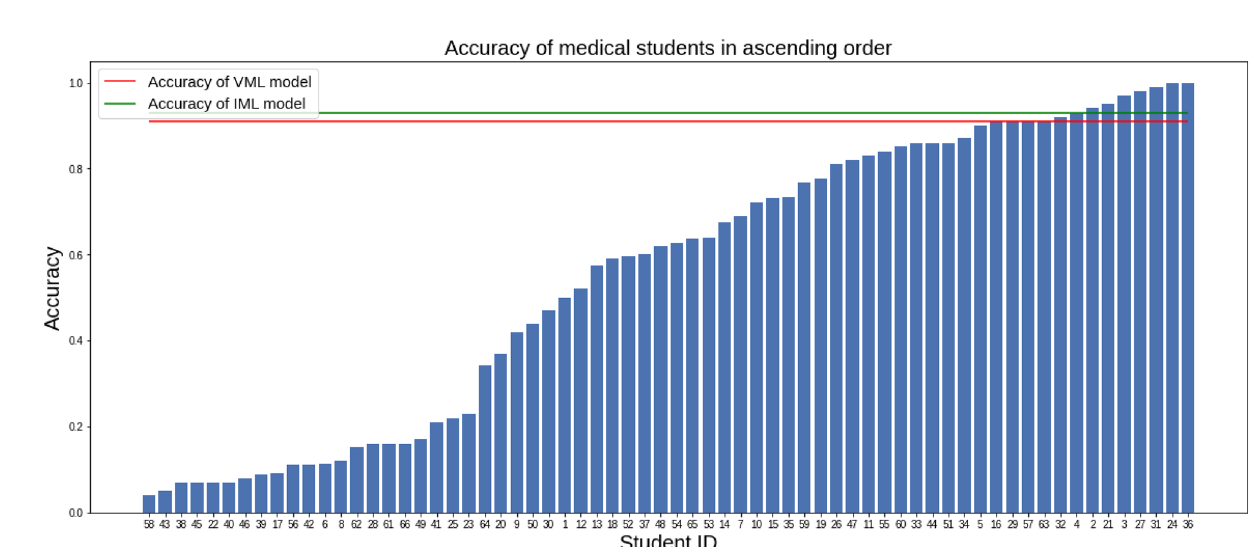
Figure 7. Accuracy of 66 medical students in ascending order (Figure generated by Matplotlib python library, version 3.3.4, https:// matpl otlib.